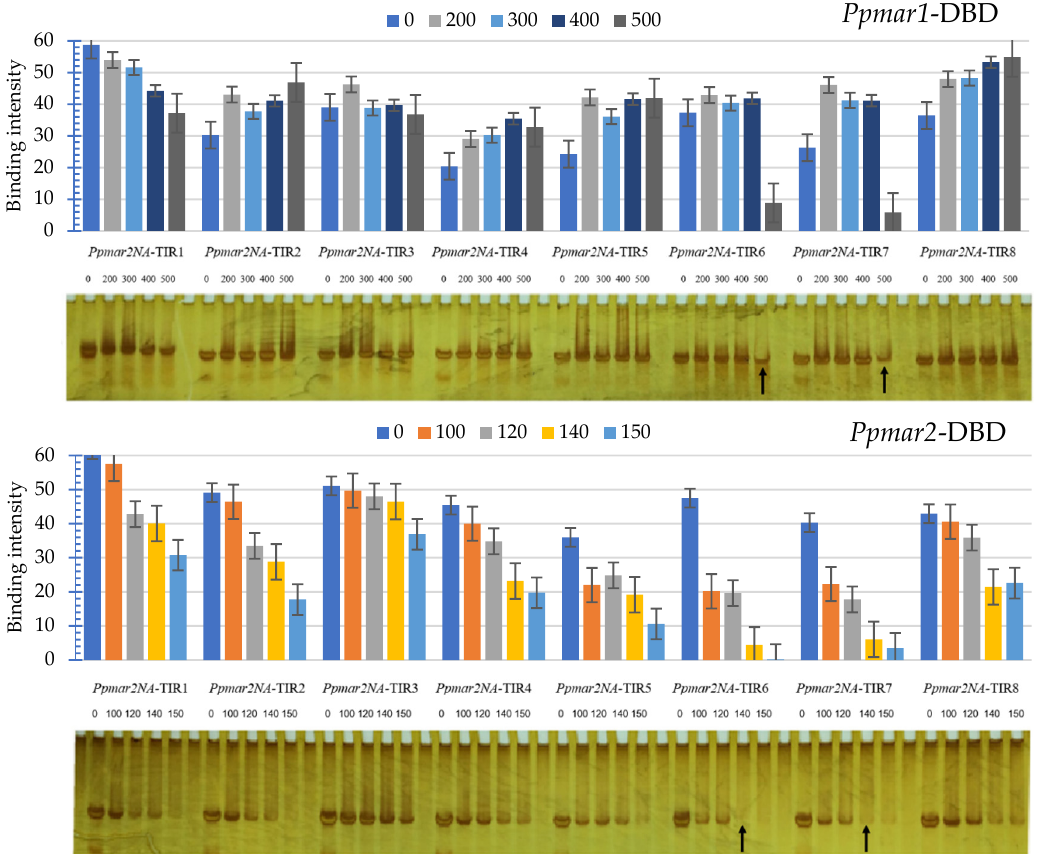
Figure 3. Electrophoretic mobility shift assays (EMSA) of mutated Ppmar2NA -TIRs 1–8, obtained with different concentrations of Ppmar1 -DBD and Ppmar2 -DBD. The concentration varied between 0 and 500 µM for the former and 0 and 150 µM for the latter. Black arrows indicate the highest interactions of mutated Ppmar2 -TIRs and DBD forming the bound complex, as shown by the relative scantiness of Ppmar2NA -TIRs in the corresponding lanes. The error bars indicate standard errors.